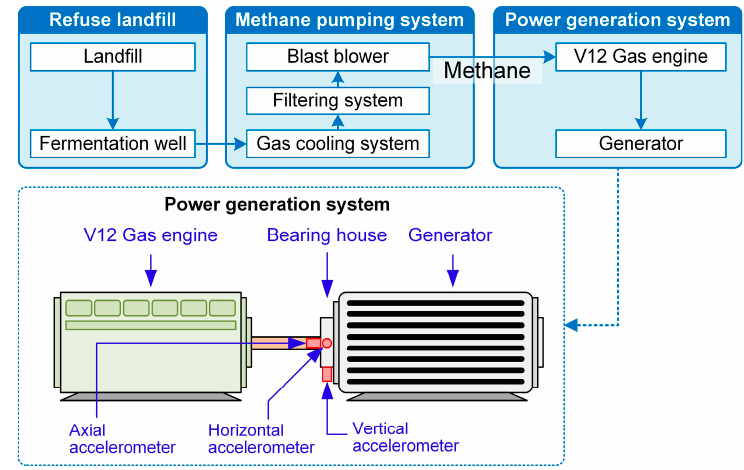
Figure 7. Schematic diagram of landfill gas power generator.